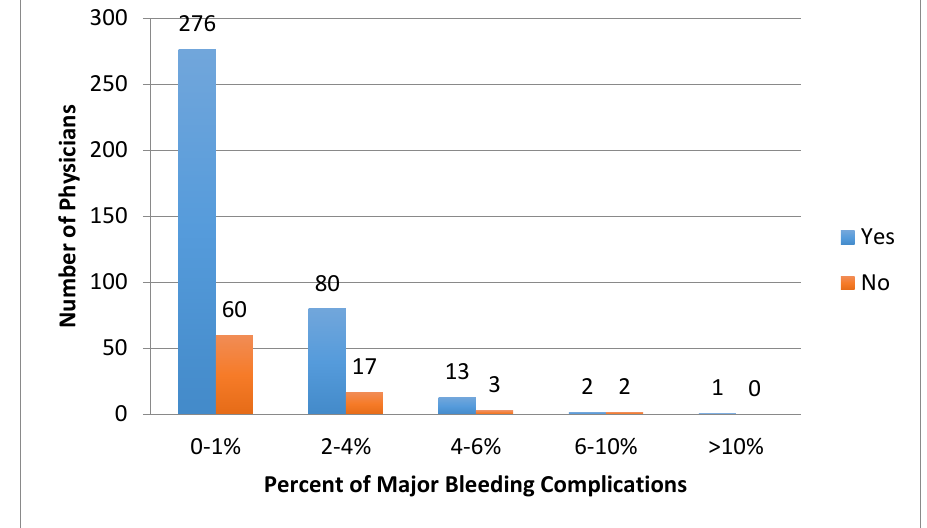
a broad range of protocols of heparin use, including those that are weight-based, protocol-driven, or partial thromboplastin time (ptt)-driven (Table 2). The majority of practitioners ( n = 374; 82.2%) monitor hemoglobin and hematocrit monitor hemoglobin and hematocrit levels.